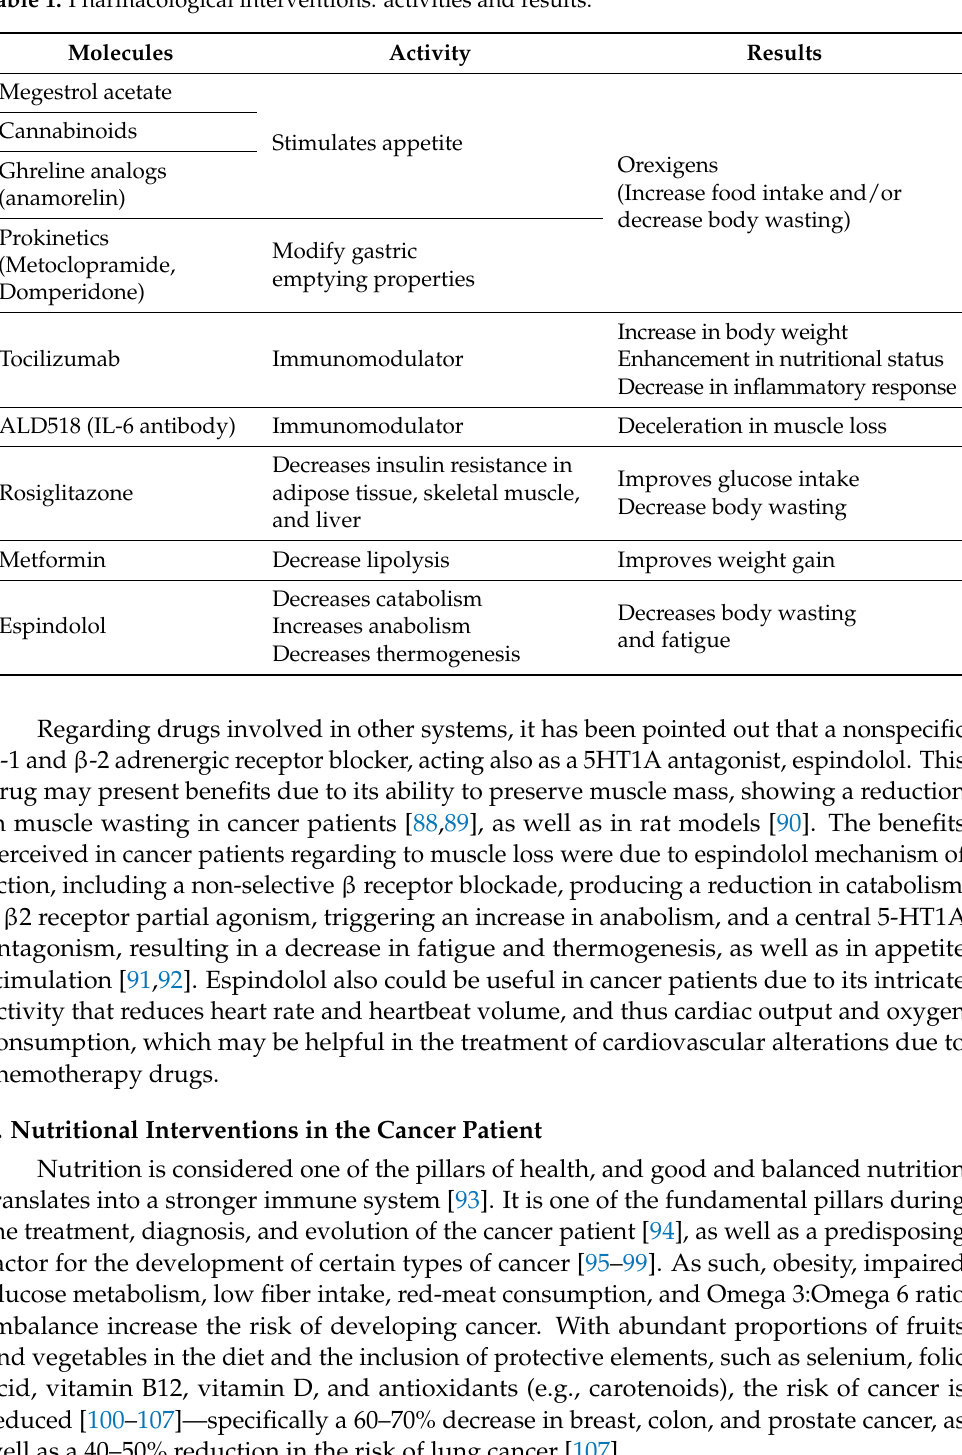
Table 1. Pharmacological interventions: activities and